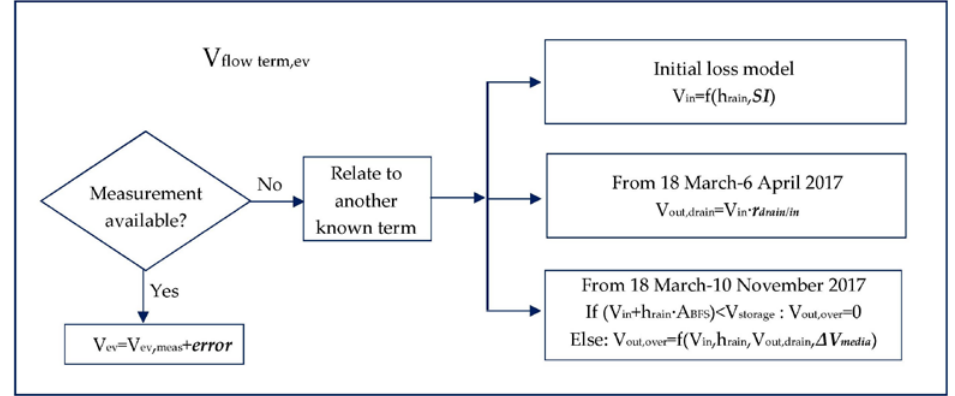
Figure 3. Generalized method for evaluating flow volumes in and out of the biofilter.